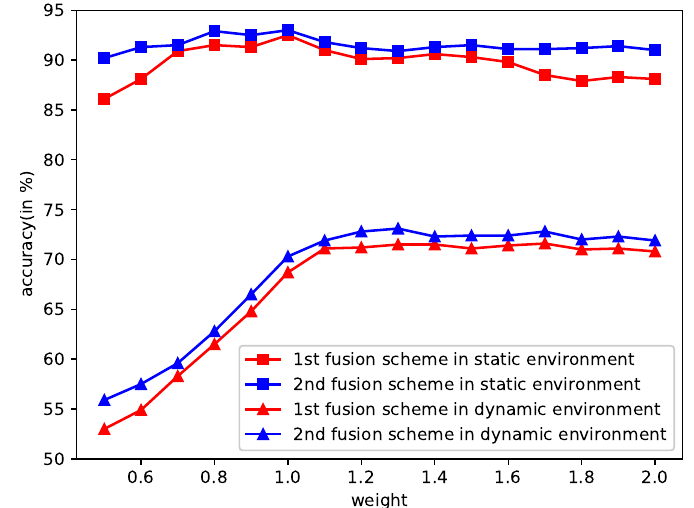
Figure 6. Normalized confusion matrices (in %) of SVM-based terrain classification on a sample set S 2 . NG, AR, CP, AG, SB, PT denote natural grass, asphalt road, cobble path, artificial grass, sand beach, plastic track, respectively.